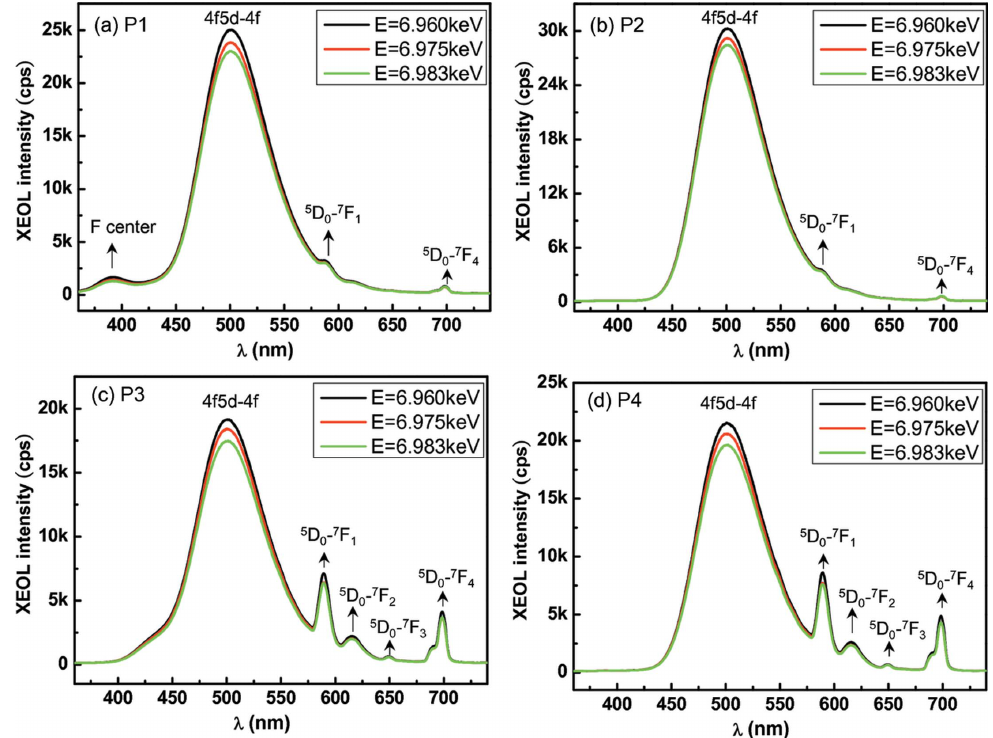
Figure 4 ( a )–( d ) Room-temperature XEOL spectra of the four local areas marked with the white dashed circles in Figs. 3( a )–3( d ). The XEOL spectra corresponding to each of the four local areas were acquired at three X-ray energies: below the Eu L 3 -edge (6.960 keV), at the Eu 2+ resonance (6.975 keV) and at the Eu 3+ resonance (6.983